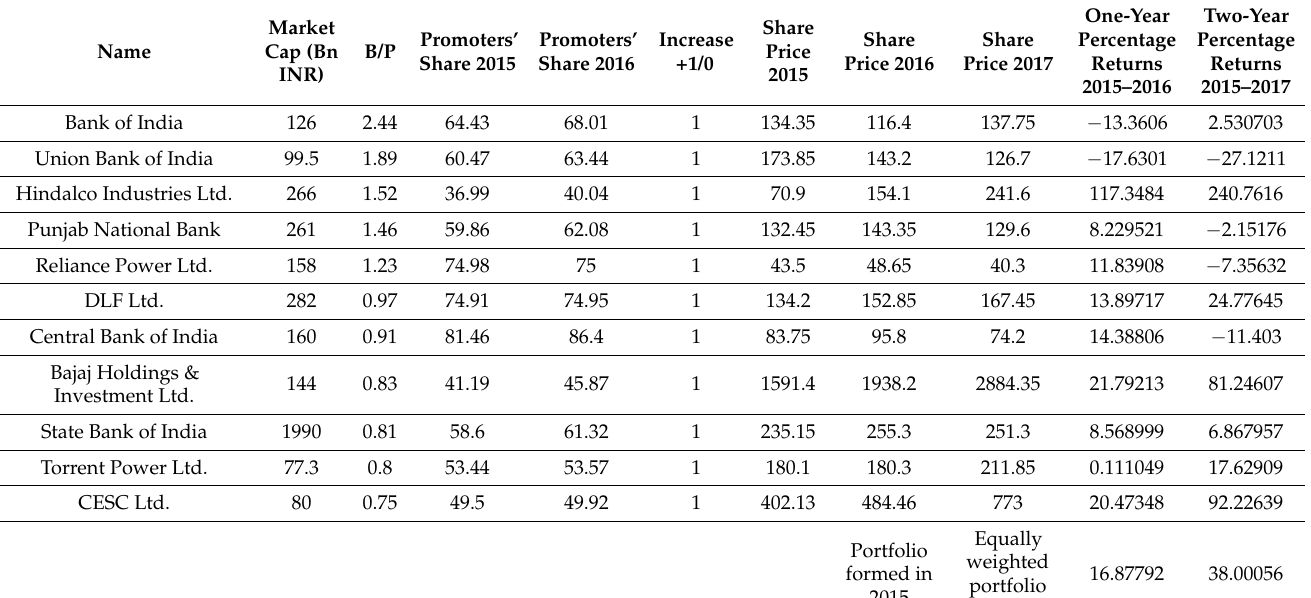
Table 5. Portfolio 2015 (financial details of small-cap companies whose promoter holdings increased in a year).